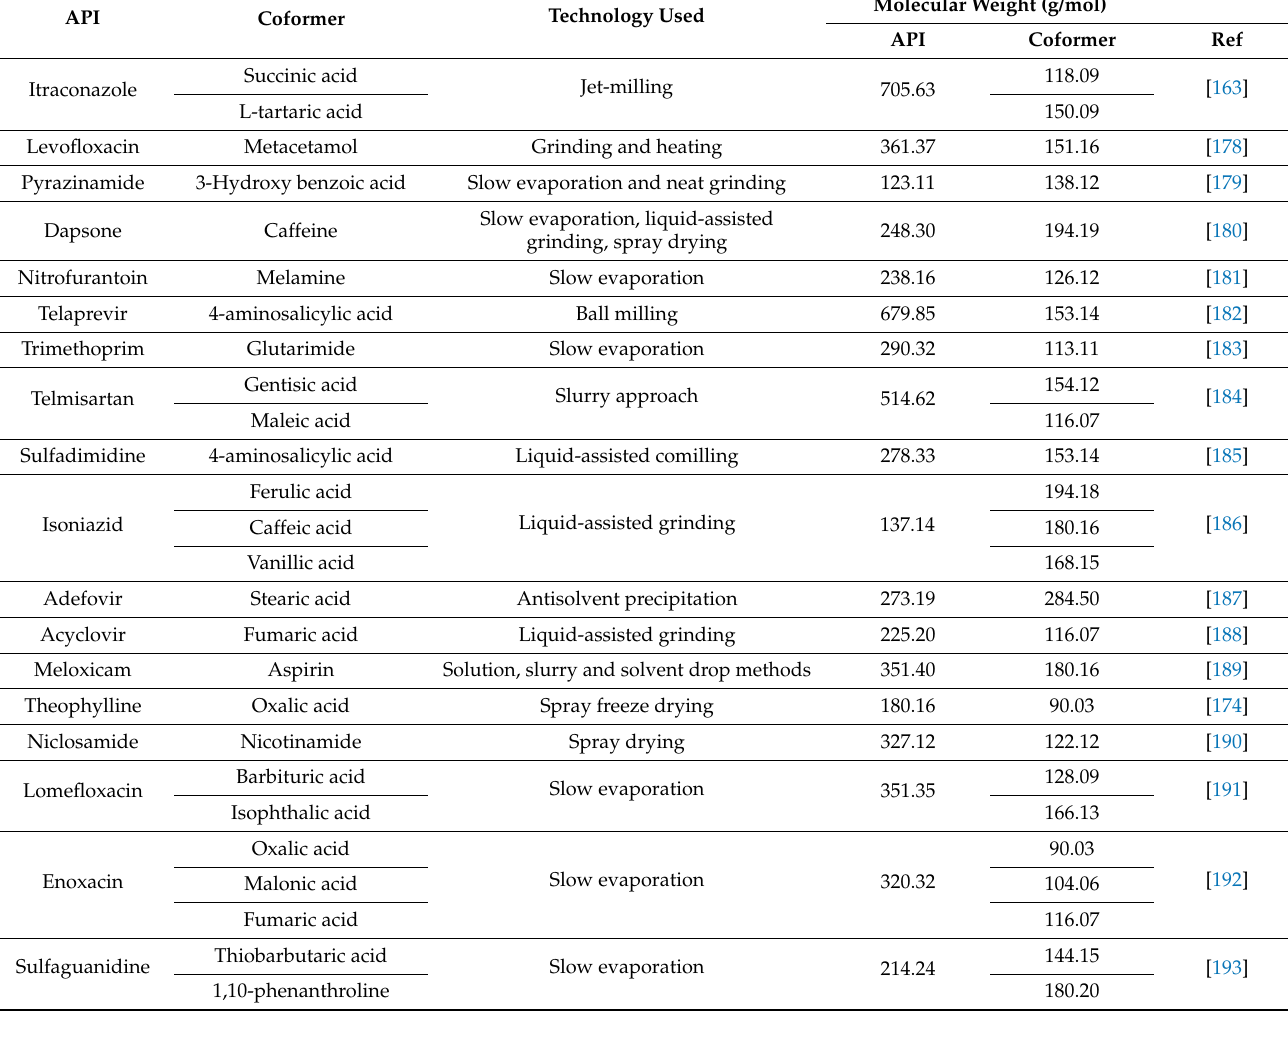
Table 8. Cocrystalline APIs, their coformers, technology used and molecular weights.